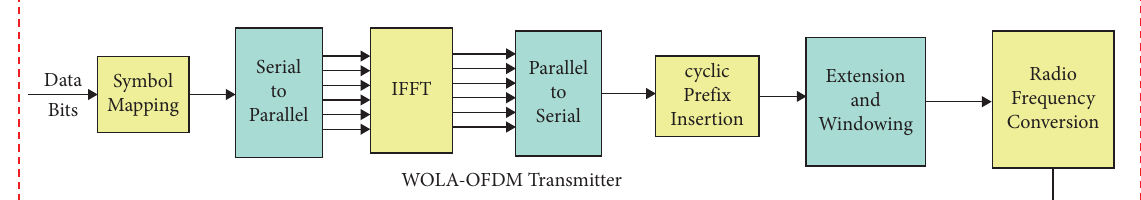
Figure 2: Filtered orthogonal frequency division multiplexing.